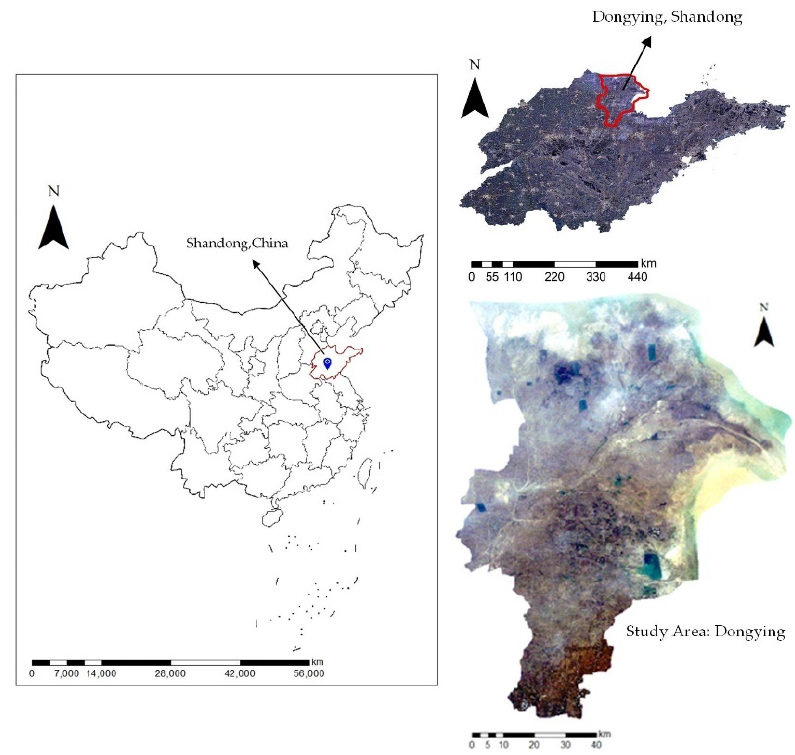
Figure 1. Study area: Dongying City, Shandong Province, China.